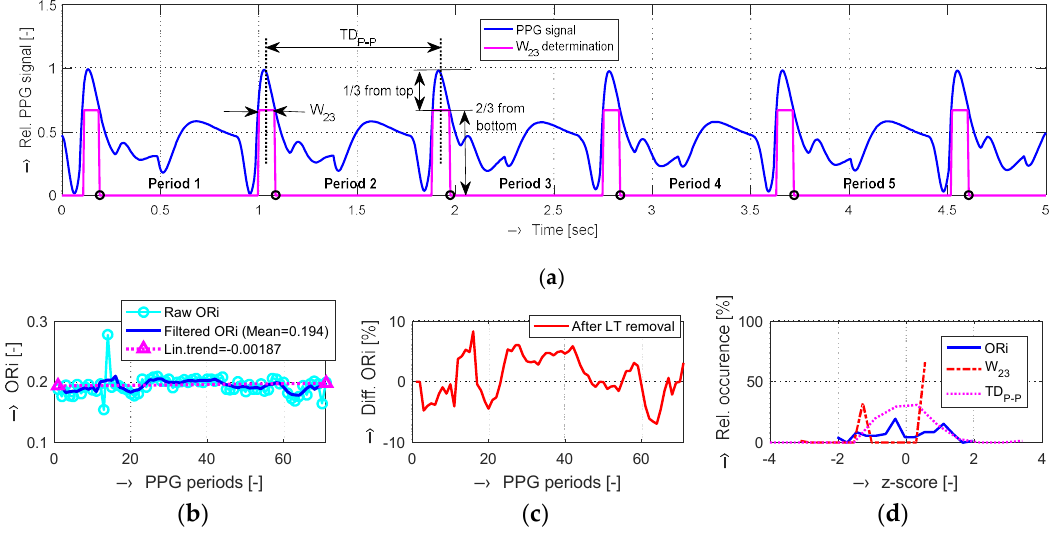
Figure 2. An example of PPG signal processing: ( a ) a 5 s region of interest (ROI) of a down-sampled signal after application of the absolute value operation (originally recorded at f s = 2 kHz, total time duration was 72 s) with localized peaks and determined parameters W 23 and TD P-P ; ( b ) raw and filtered Oliva–Roztocil index (ORi) values with the finally calculated linear trend (LT) of the whole PPG signal record; ( c ) differential ORi after LT removal; ( d ) histograms of z-scores calculated from the ORi, W 23 , and TD P-P values.